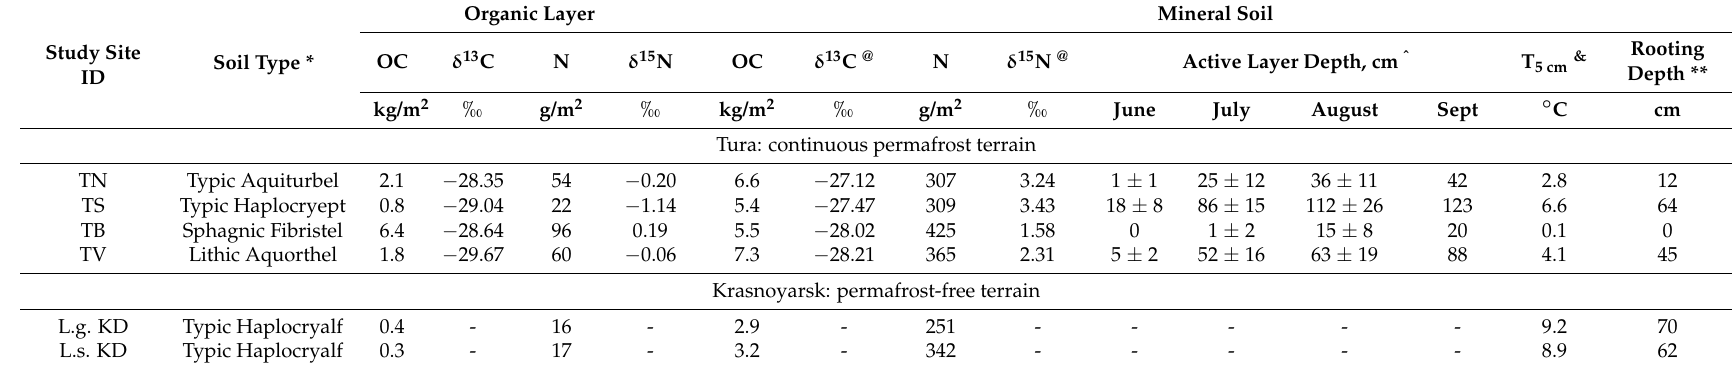
Table 2. Soil characteristics of sites in Tura (permafrost region) and Krasnoyarsk (permafrost-free region). Data presented as mean ( ± SD).